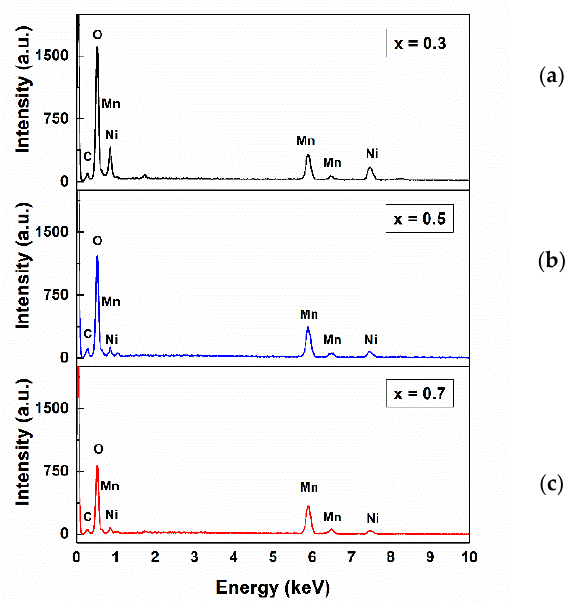
Figure 4. EDS spectra of ( a ) Ni 0.35 Mn 0.65 CO 3 , ( b ) Ni 0.25 Mn 0.75 CO 3 , and ( c ) Ni 0.15 Mn 0.85 CO 3 powders, the results of the first step of the synthesis process.